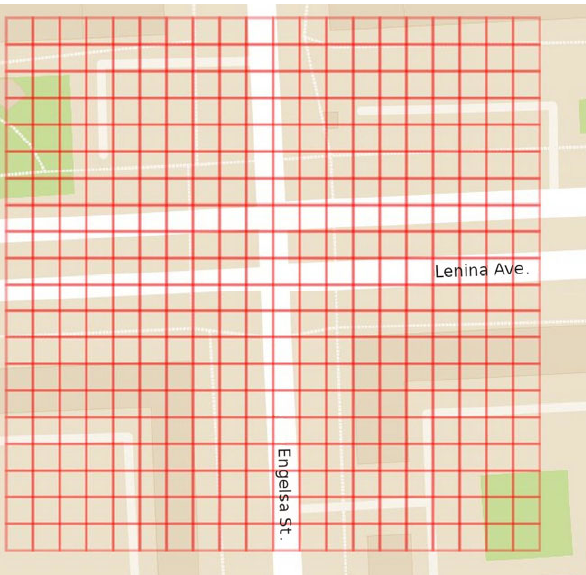
Figure 4. Grid of 20 × 20 m squares at an intersection in Chelyabinsk, Russia.